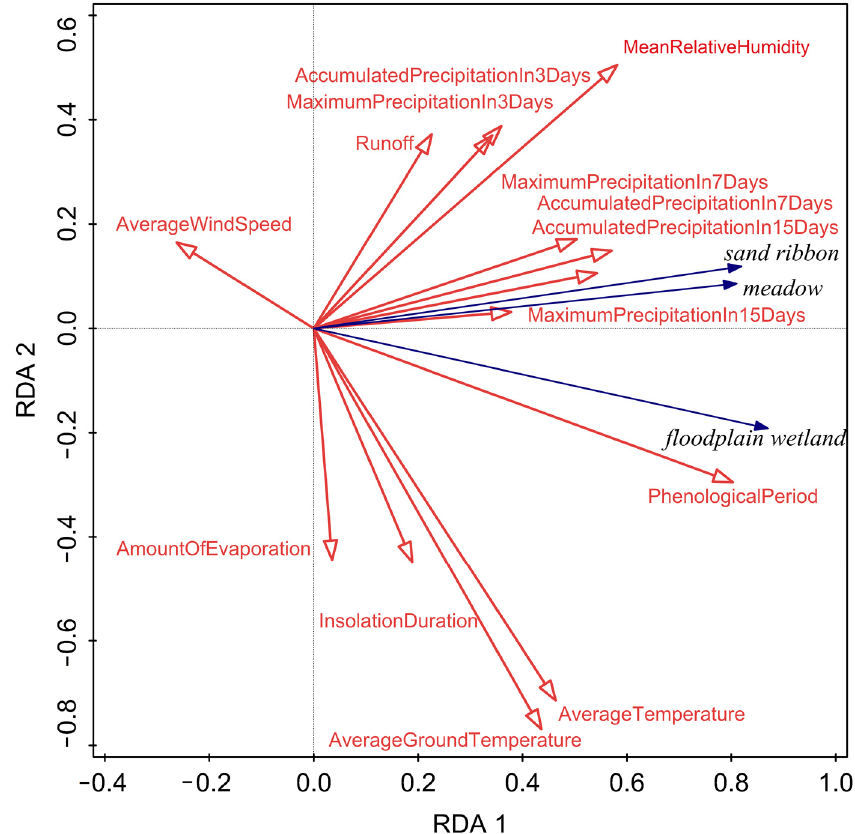
Figure 5. Biordered graph of RDA. RDA 1 represents the fitting value. RDA 2 represents the regression residual. The direction of the arrow indicates the value increases; its length is proportional to the maximum rate of change. The angle between arrows reflects the correlation. The acute, obtuse, and vertical angles represent positive, negative, and non-correlation, respectively.